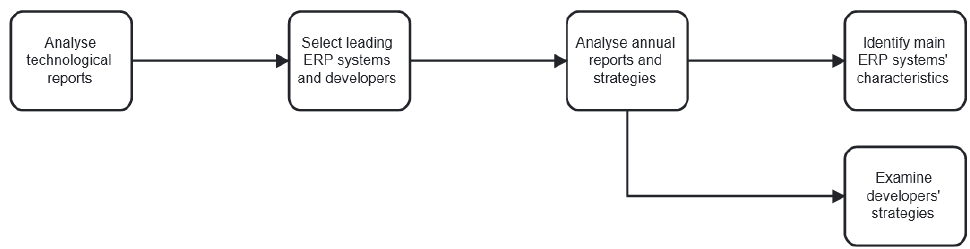
Figure 1. ERP systems and analysis of leading developers. Source: authors’ construction.